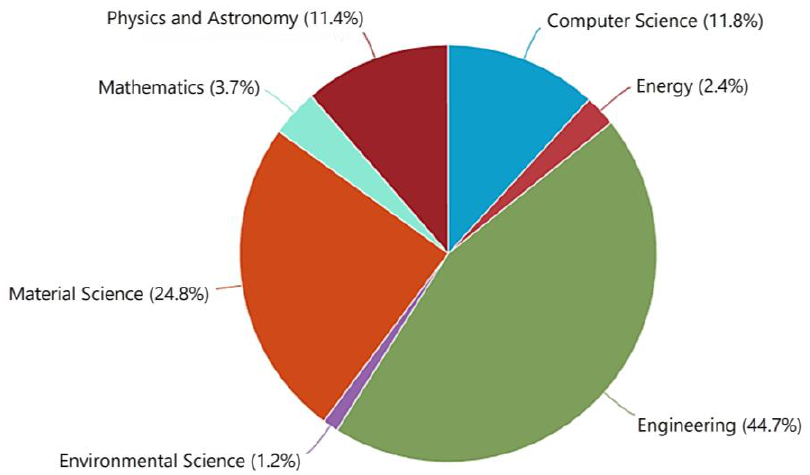
Figure 5. Fields of the publications according to Scopus search results .